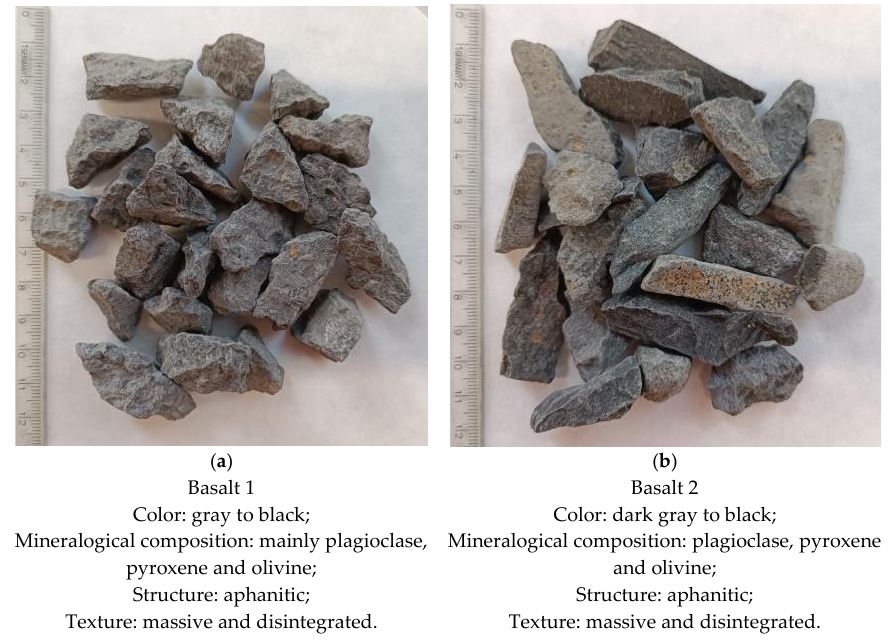
Figure 1. Illustration of two basaltic samples (( a ) basalt 1; ( b ) basalt 2) tested in this study. Table 1. Average physical and mechanical properties values of two basaltic samples.